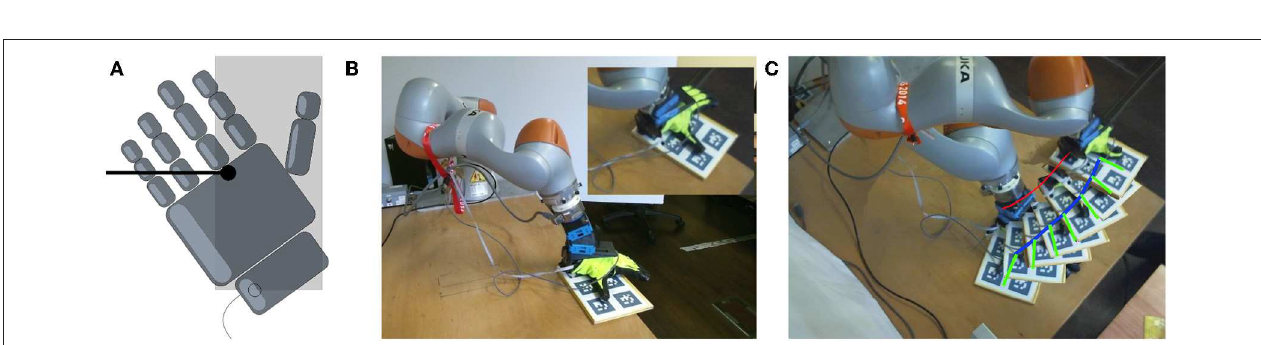
FIGURE 2 | Strategy 1 Continuous Slide and Grasp–overview. (A) Hand placement, (B) desired final pose, (C) example trajectory (blue: object CoM; red: end-effector; green: object